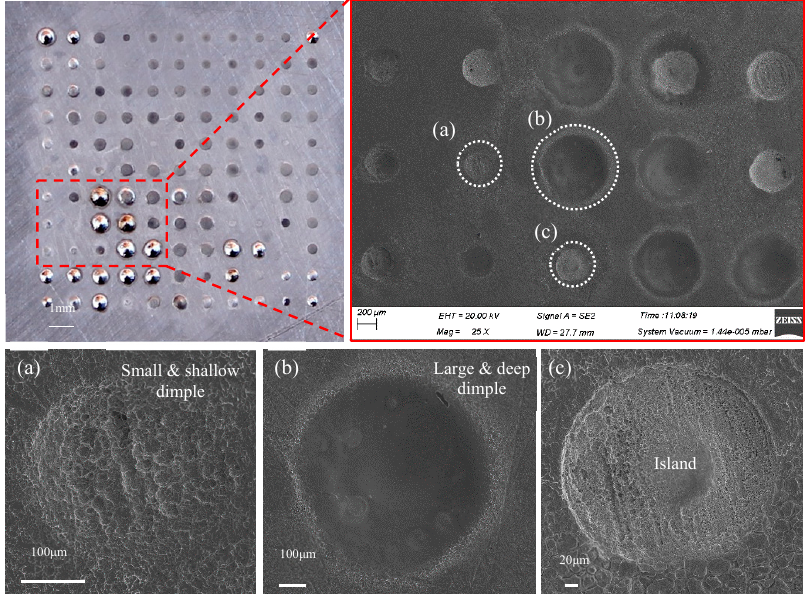
Figure 9. Morphologies of the arrayed micro ‐ dimples machined in the double ‐ travel mode and with the magnetic field (double ‐ travel time of 0.3 (cid:3400) 2 s, 8.5 V).